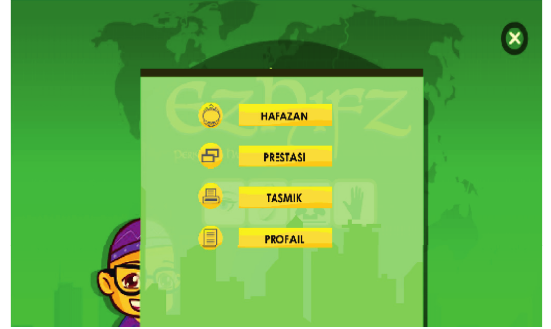
Figure 2: Main menu.